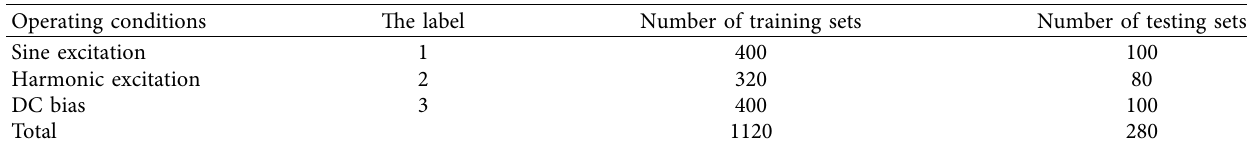
Table 1: Distribution of core sound database sample.